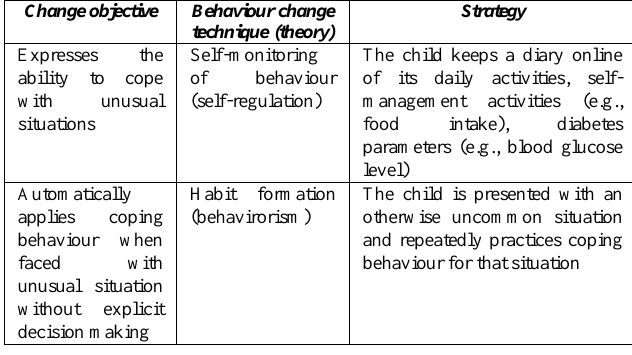
M APPING TECHNIQUES ON CHANGE OBJECTIVES AND DESCRIPTION OF STRATEGY OF INTERVENTION